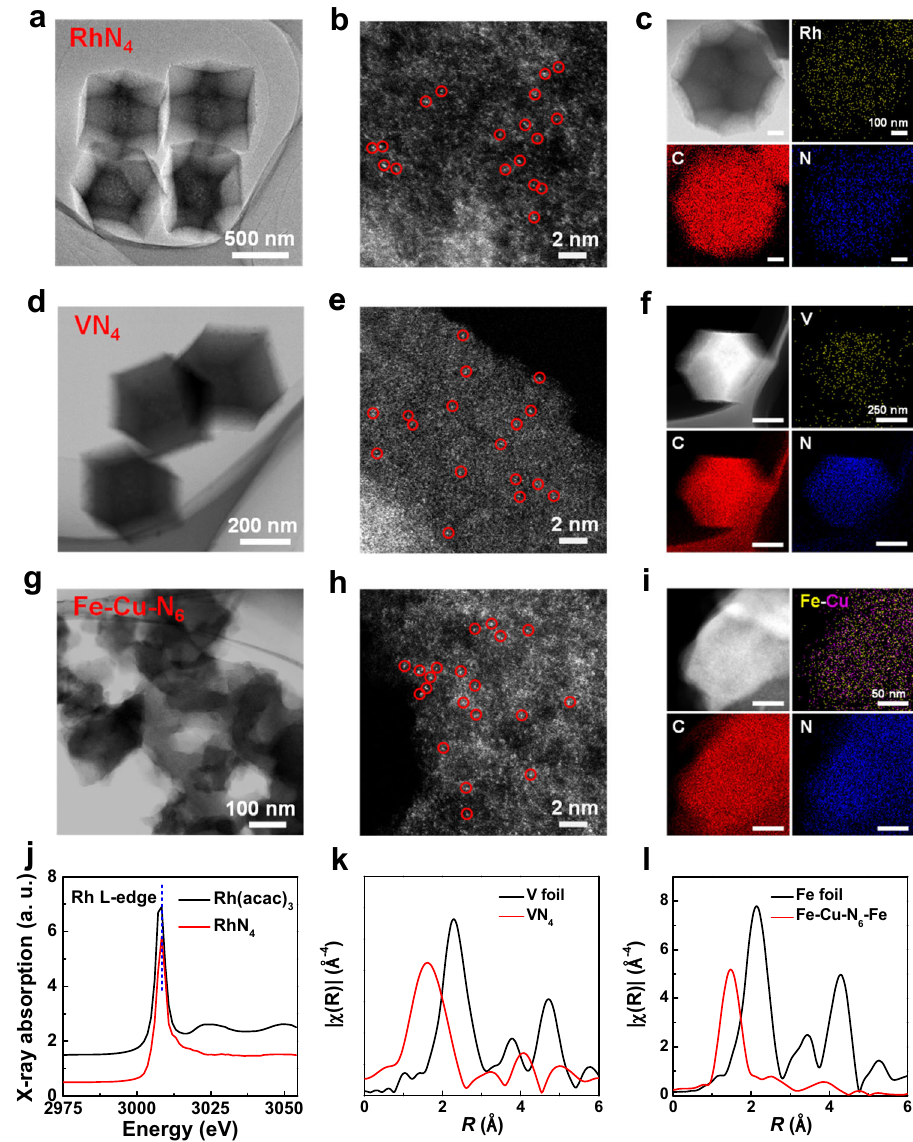
Fig. 2 | Structural characterization of MN x . TEM, AC-HAADF-STEM, and corre- spondingEDSmappingimagesof a – c RhN 4 , d – f VN 4 ,and g – i Fe-Cu-N 6 ,respectively ( n =3 images from three independent samples).Singlemetalatoms highlightedby red circles. j XANES spectra of RhN 4 and the Rh(acac) 3 reference at the rhodium